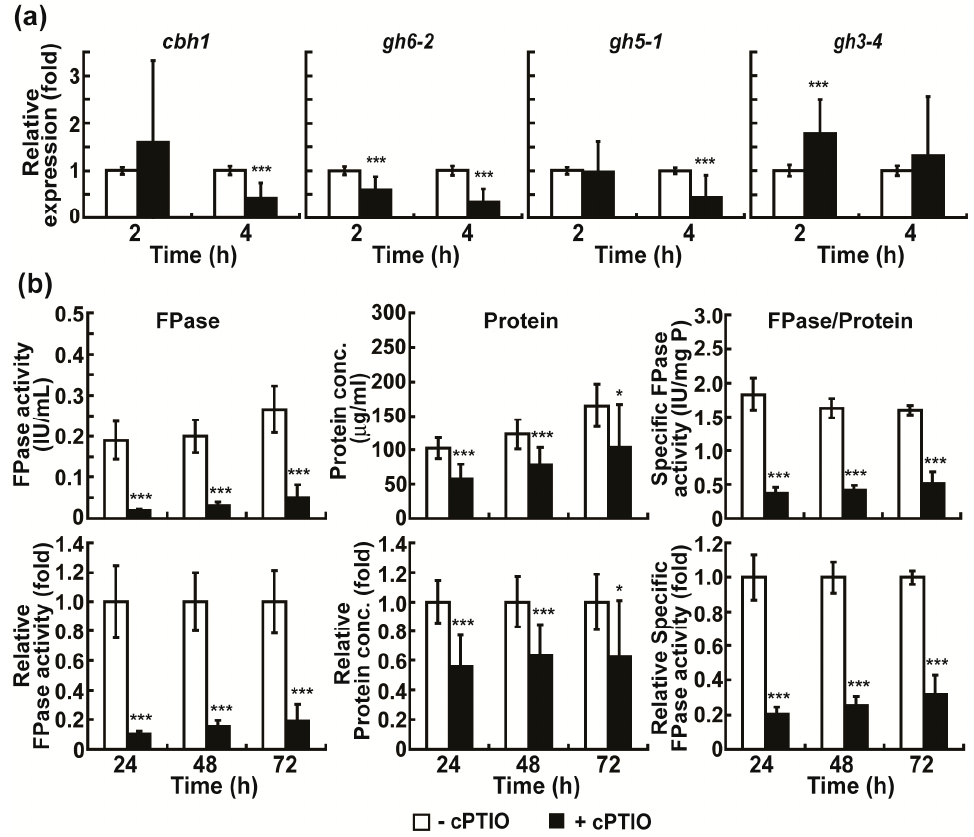
Figure 5. Effect of cPTIO treatment on cellulolytic enzyme production. ( a ) mRNA levels of cellu- lolytic enzymes ( cbh1 , gh6-2 , gh5-1 , and gh3-4 ) in fungal hyphae grown in Avicel medium with or without cPTIO for 2 and 4 h. ( b ) FPase activity (total activity of cellulolytic enzymes), total protein concentration, and specific enzyme activity measured in media after fungus was grown in Avicel medium with or without cPTIO for 24, 48, and 72 h. − cPTIO group: only Avicel medium, +cPTIO group: 10 mM cPTIO in Avicel medium. Each value is the mean of 9 or 12 replicate measurements (three replicates per experiment and three or four independent experiments): * p < 0.05, *** p < 0.001 as determined by Student’s t -test.